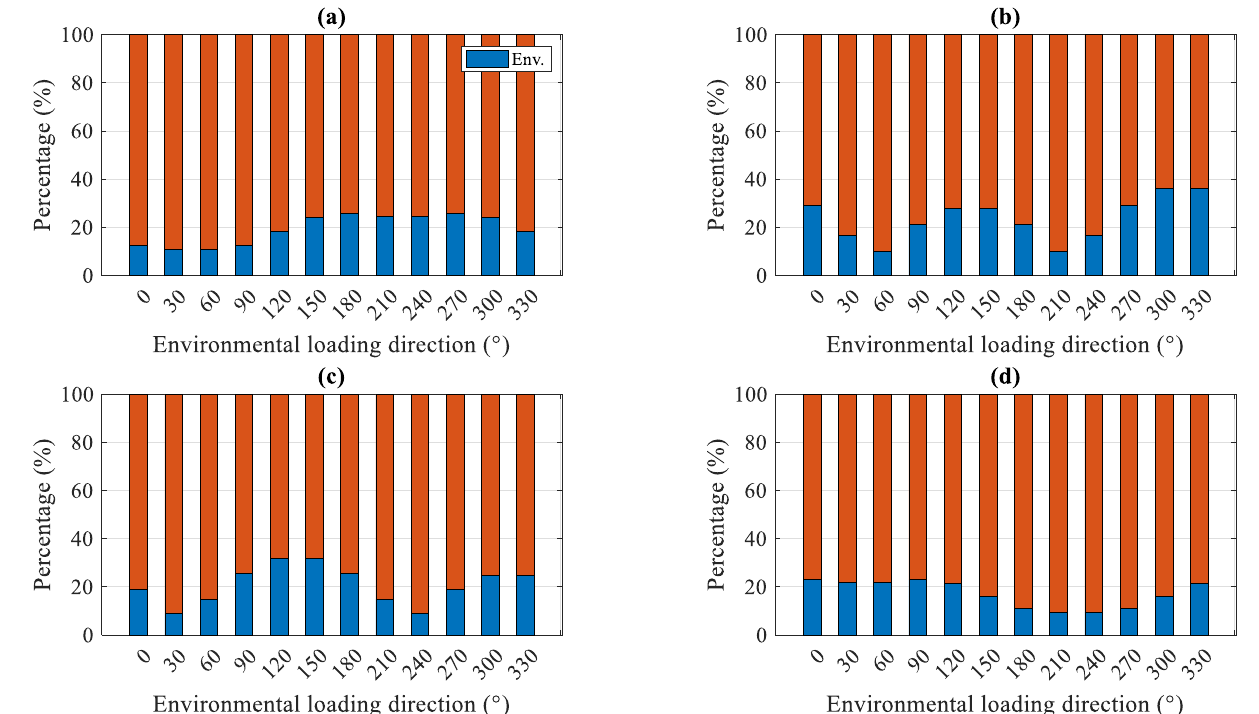
Figure 13. Percentage contribution of Env loads (stress): ( a ) Leg 1; ( b ) Leg 2; ( c ) Leg 3; ( d ) Leg 4.